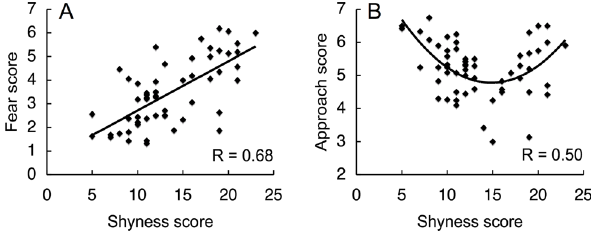
Figure 1. Relationship between shyness and other tempera- ments. (A) Fear scores (vertical axis) correlate linearly with shyness scores (horizontal axis). The solid line represents a regression line of the distribution. (B) Approach scores (vertical axis) correlate secondarily with shyness scores (horizontal axis). The solid line represents a secondary regression curve of the distribution. R: Correlation coefficient.